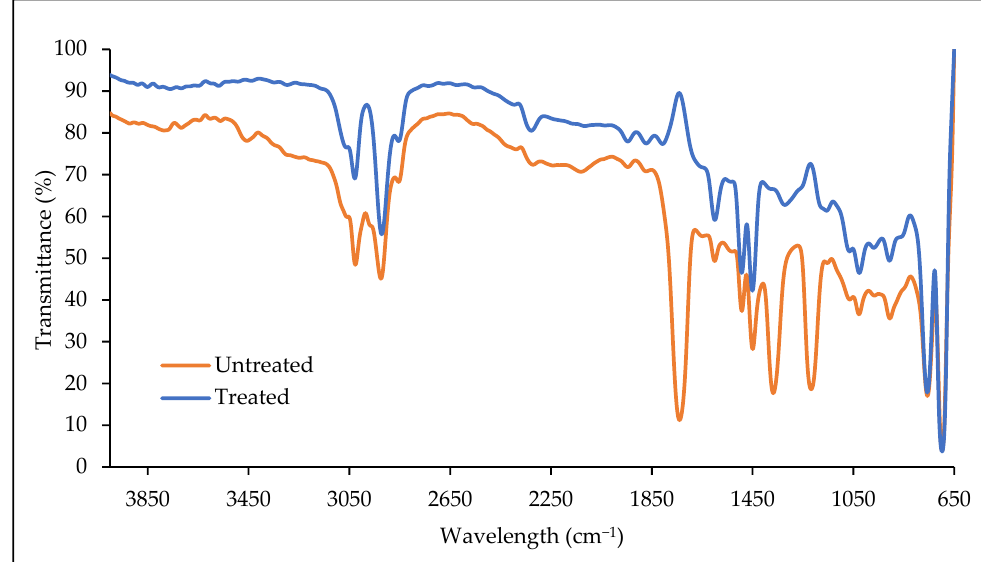
Figure 5. Fourier transform infrared (FTIR) spectra of untreated PS microplastics and treated PS microplastics after incubation with AYDL1 for 40 days in BH medium.